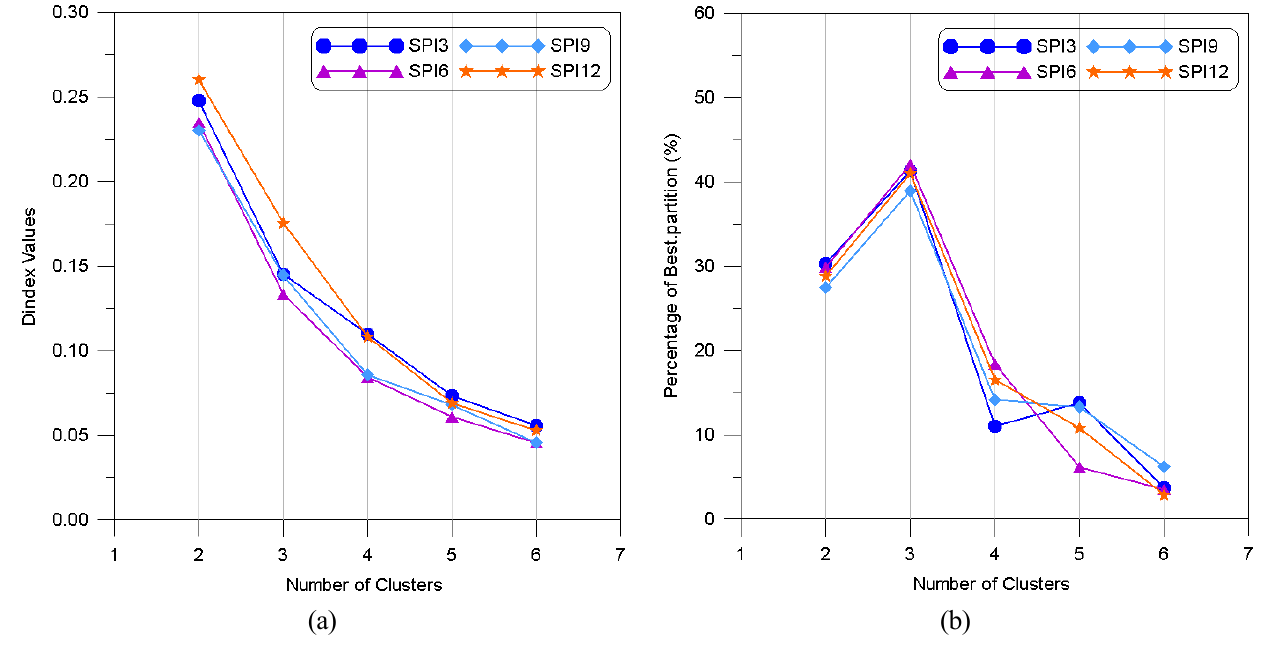
Figure 8. Setting the number of clusters for cluster analysis: (a) D index; (b) Best.partition. The SPI by duration of Gyeongsangnamdo based on cluster analysis was analyzed using three clusters, as shown in Figure 9. The minimum value of SPI3 ranged from − 3.30 to − 2.96 and the maximum value ranged from 1.80 to 2.96. On the other hand, the minimum value of SPI6 ranged from − 2.94 to − 2.37 and the maximum value ranged from 1.69 to 2.57. Meanwhile, the minimum value of SPI9 ranged from − 2.37 to − 2.02 and the maximum value ranged from 1.82 to 2.82. Moreover, the minimum value of SPI12 ranged from − 2.50 to − 1.95 and the maximum value ranged from 1.72 to 2.97. The analysis results of SPI by duration showed that the minimum value ranged from − 3.30 to − 1.95 and the maximum value ranged from 1.69 to 2.97. The difference in the cluster analysis of SPI by duration was 1.35 for the minimum value and 1.28 for the maximum value.